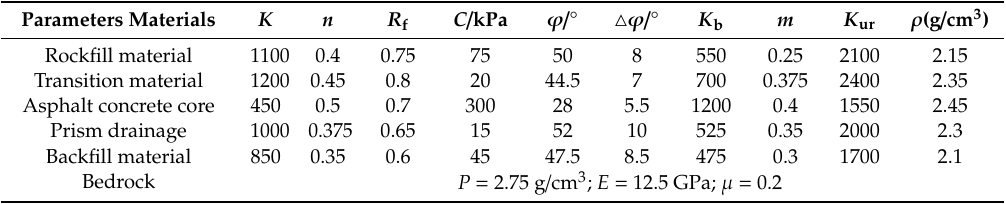
Table 1. Characteristic parameters of dam materials (E-B model).